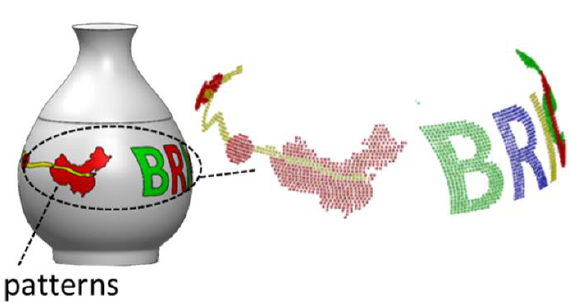
Figure 1. Single-point color nozzle.